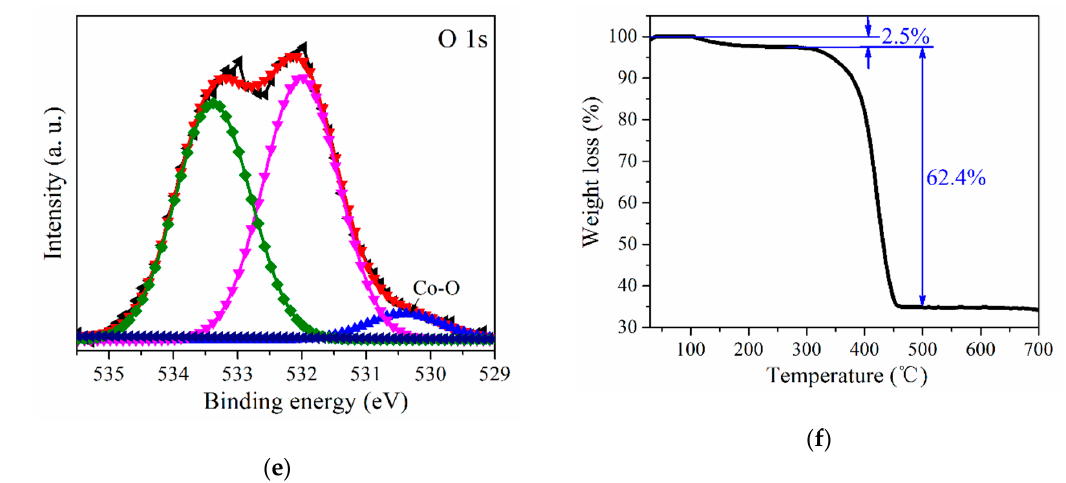
Figure 5. XPS survey spectra and thermogravimetric (TG) curve of samples: ( a ) Wide scan spectra of AG and the Co 3 O 4 /AG nanocomposite; ( b ), ( c ), ( d ), and ( e ) high-resolution Co 2p, C 1s, N 1s, and O 1s spectra of the Co 3 O 4 /AG nanocomposite; ( f ) TG curve of the Co 3 O 4 /AG nanocomposite.